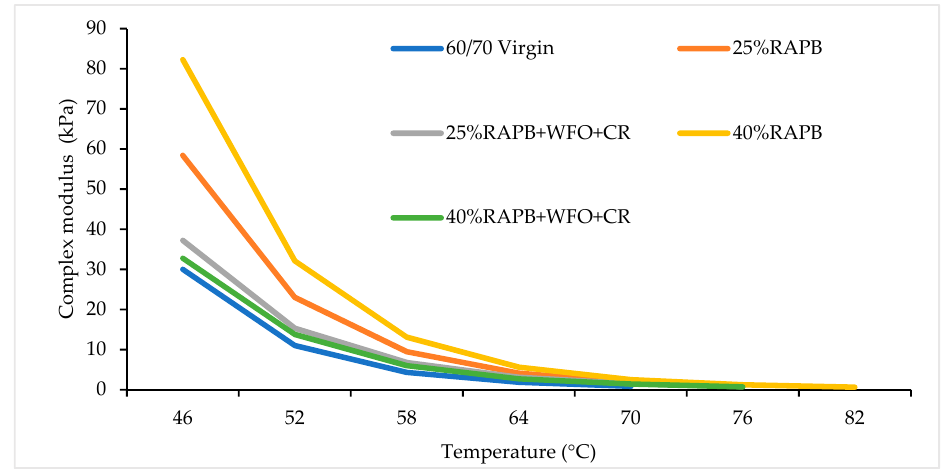
Figure 12. Complex modulus results of all binders.